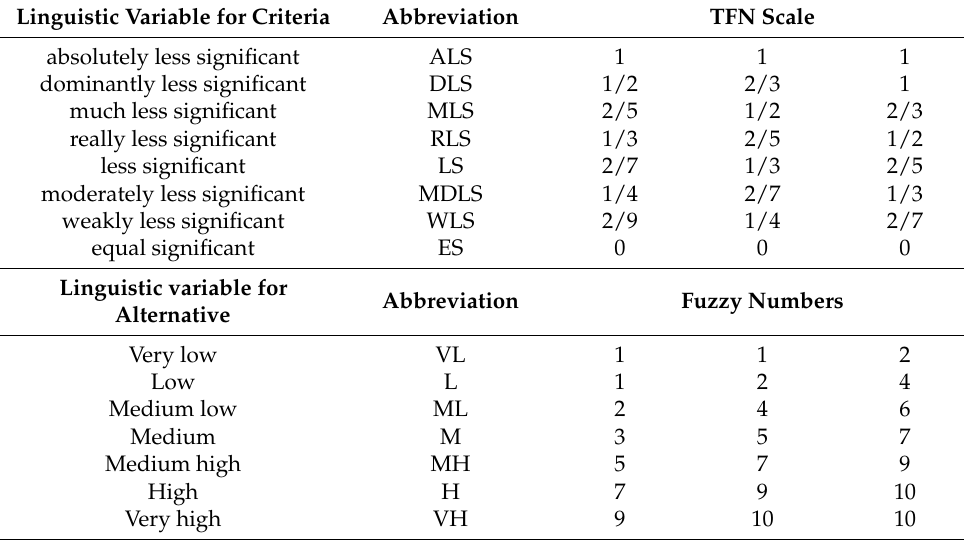
Table 4. Linguistic values and belonging to fuzzy